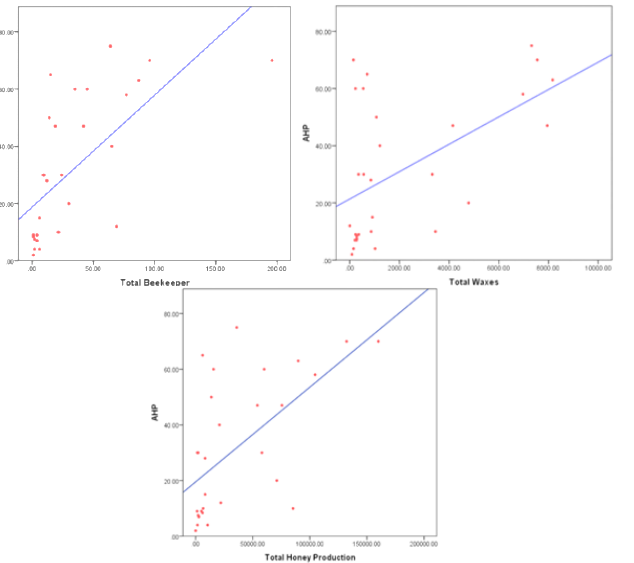
Figure 5. Correlation graphics (r=0,66, r=0,54,